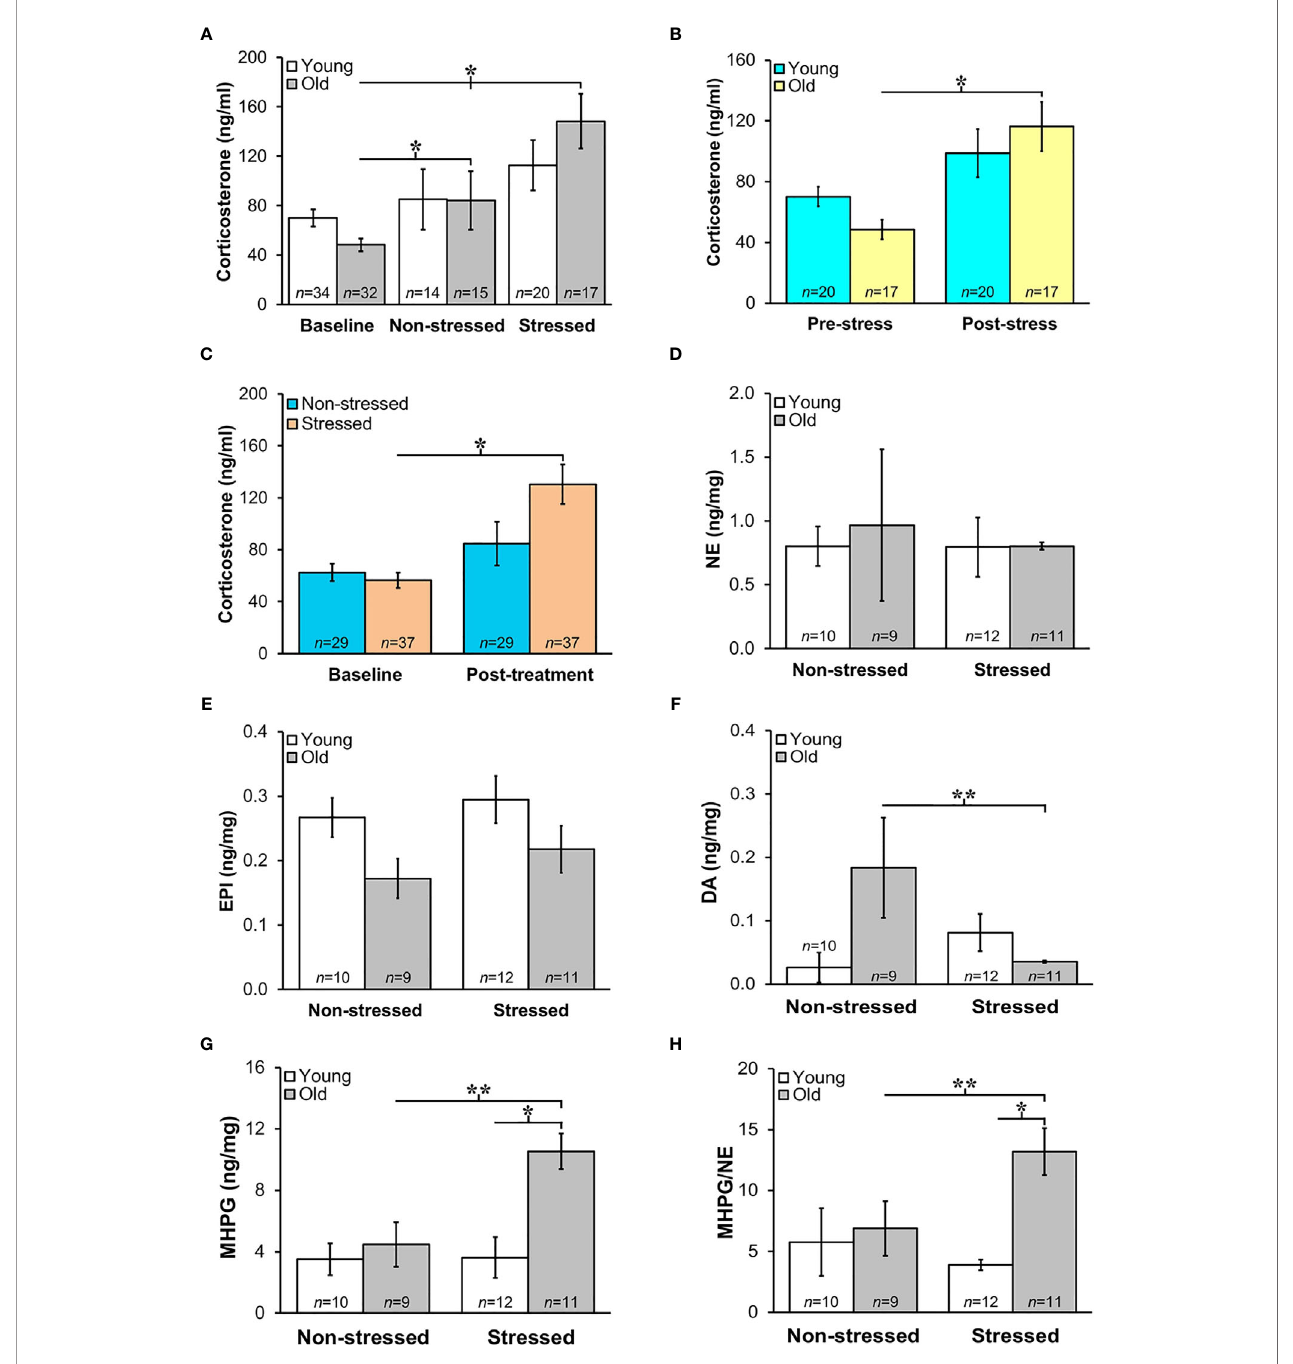
FIGURE 4 | (A) Increased HPA and SNS Activation in Stressed Old Mice. Mean circulating corticosterone levels (ng/ml ± S.E.M) from young and old non-stressed and stressed mice at baseline and D15 post-tumor inoculation. Old stressed mice had a signi fi cant increase in corticosterone levels post-treatment than at baseline. (B) After data are collapsed across age, Stressed mice had signi fi cantly higher corticosterone levels than Non-stressed mice (** p < 0.02). Data are expressed as corticosterone in ng/ml ± S.E.M. *Daily restraint stress began1 day after tumor inoculation. (C) Corticosterone expressed in ng/ml was higher (* p < 0.05) post- treatment compared with baseline levels in stressed compared with non-stressed mice. (D, E) Tumor expression of NE and EPI (ng/mg) were similar in all treatment groups. (F, G) However, in old mice, prostate dopamine, a precursor in NE synthesis, was lower (** p < 0.01) in stressed than non-stressed mice, and prostate MHPG, a metabolite of NE degradation, was elevated in old stressed mice compared with old non-stressed or young stressed mice (** p < 0.01 or * p < 0.05, respectively). (H) Likewise, MHPG/NE ratios, used to estimate NE turnover, was also higher in prostate tumors from old stressed mice than from old non-stressed or young stressed mice (** p < 0.01 or * p < 0.05, respectively). * p < 0.05, ** p <